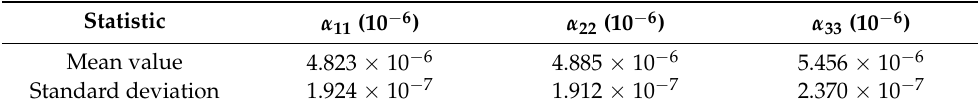
Table 7. The statistics of thermal expansion coefficient of 2D materials.